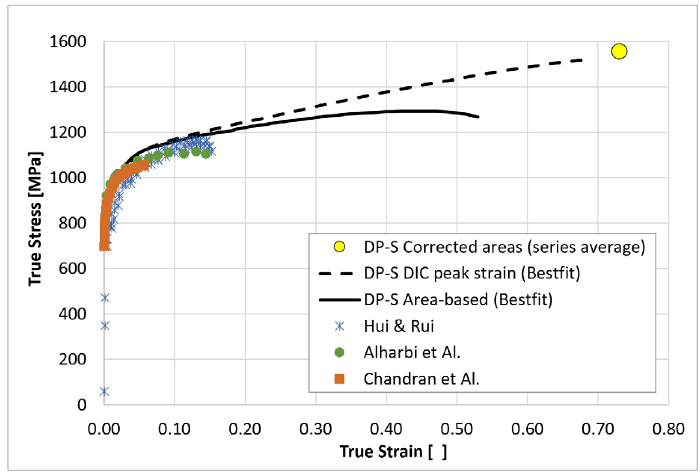
Figure 13. Comparison with true curves from the literature—steels of the class DP1000 according to different procedures.